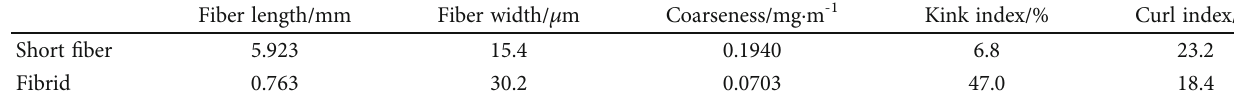
Table 1: Basic physical parameters of meta-aramid fi ber materials.